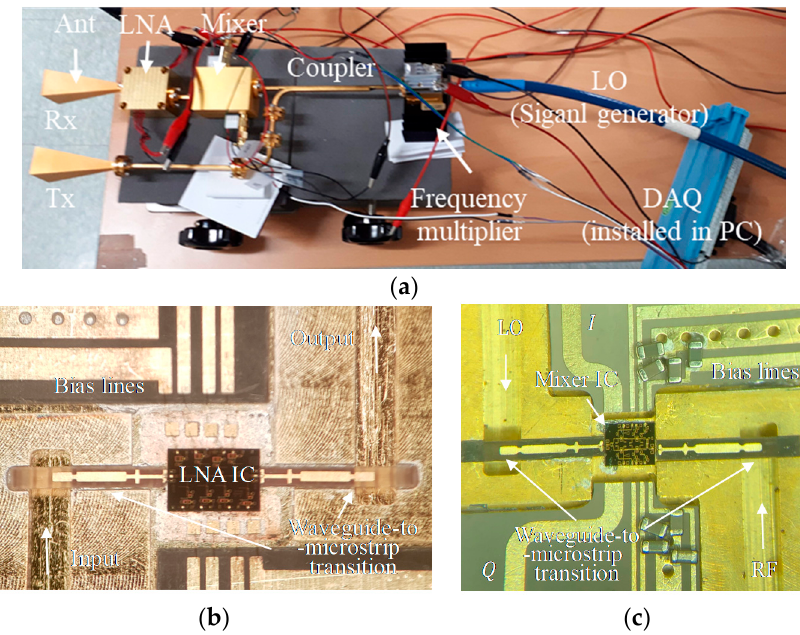
Figure 3. Fabricated W-band Doppler radar. ( a ) Overall view. ( b ) Waveguide low noise amplifier (LNA) module [15]. ( c ) Quadrature mixer module [13].